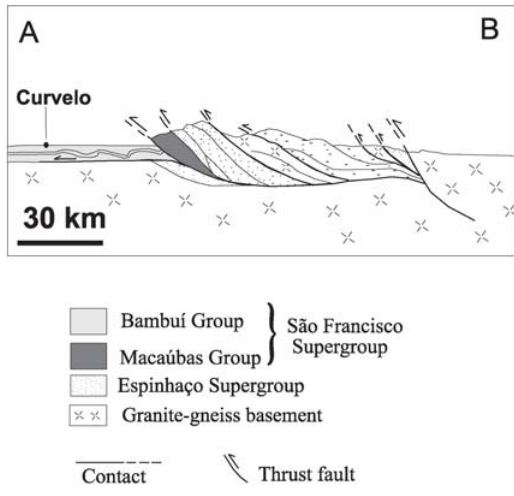
Fig. 3 – Regional W-E cross-section along the southern Serra do Espinhaço (see Fig. 1 for location) (modified after Dossin et al.